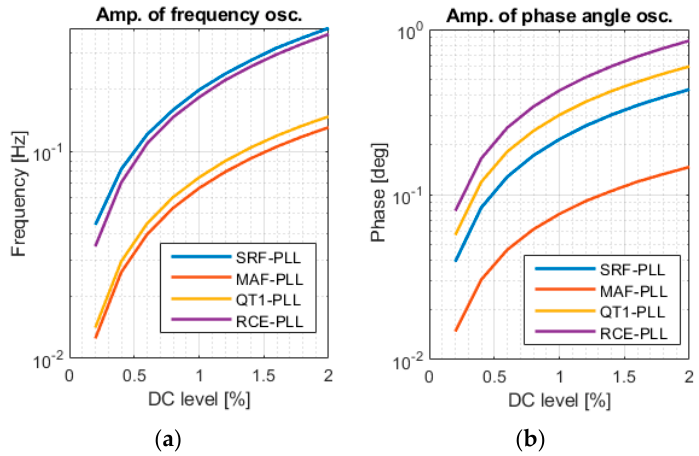
Figure 17. Effect of DC offset in phase A on the amplitude of undamped oscillations. ( a ) Frequency; ( b ) phase angle.